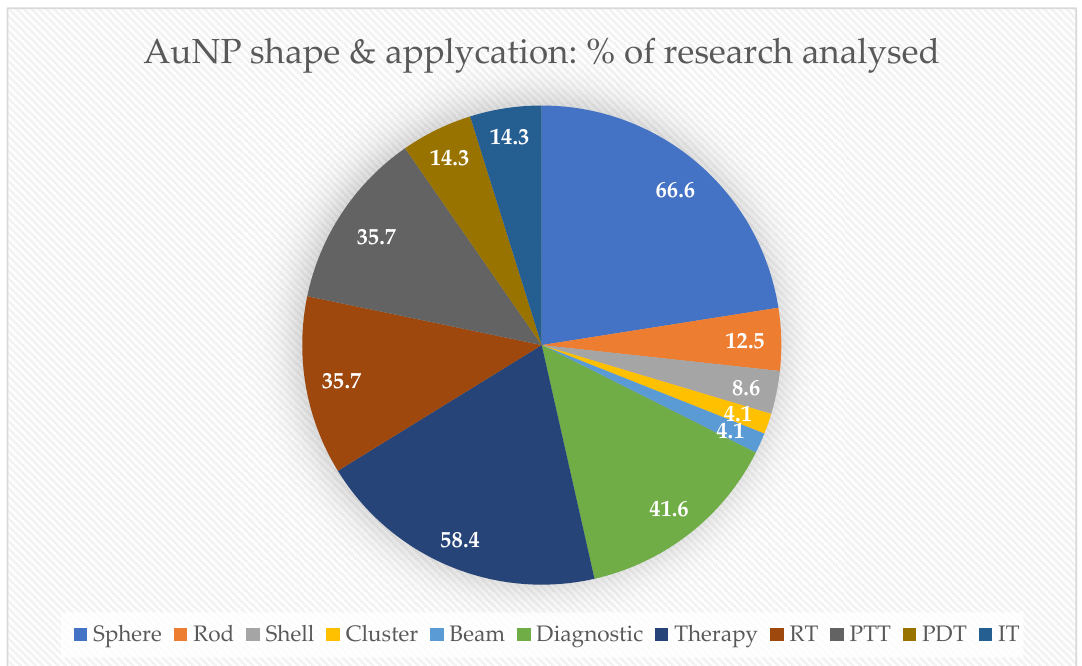
Figure 4. The gold nanoparticles’ shapes and proposals. The percentage of the most common AuNPs shown in research papers used in this state-of-the-art review for biomedical applications. IT = immunotherapy; PDT = photodynamic therapy; PTT = photothermal therapy; RT =